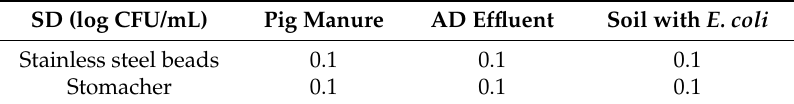
Table A3. Standard deviation of the homogenization experiments.